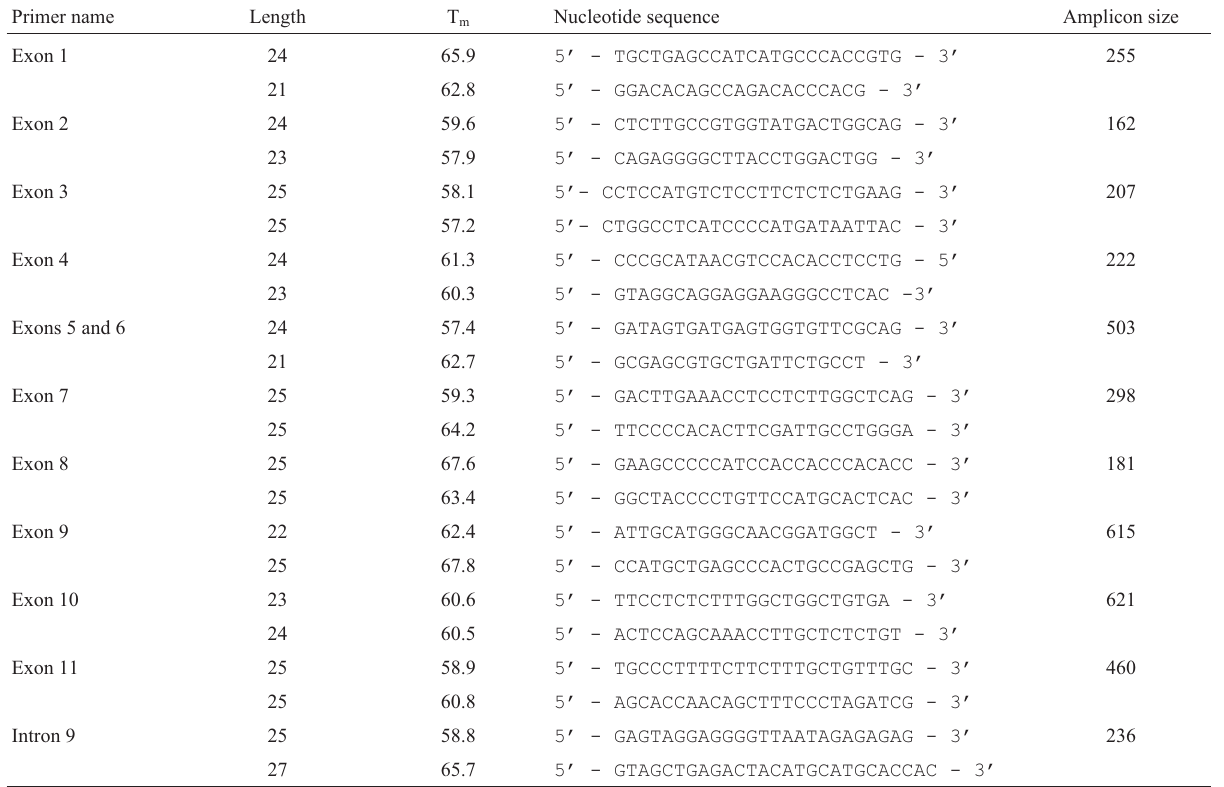
Table 1 - OCT 1 Multiplex PCR primers.